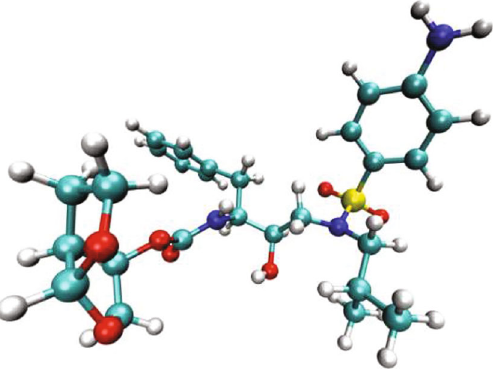
Figure 9: Molecular structure of